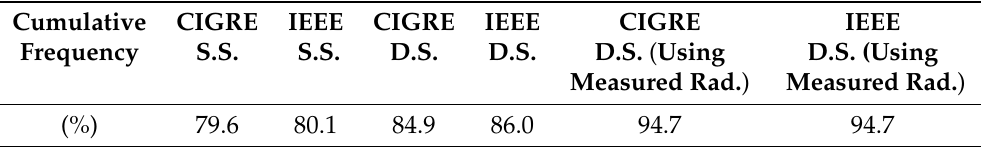
Table 3. Cumulative frequencies of deviation to conductor temperature lower than 5 ◦ C for the studied